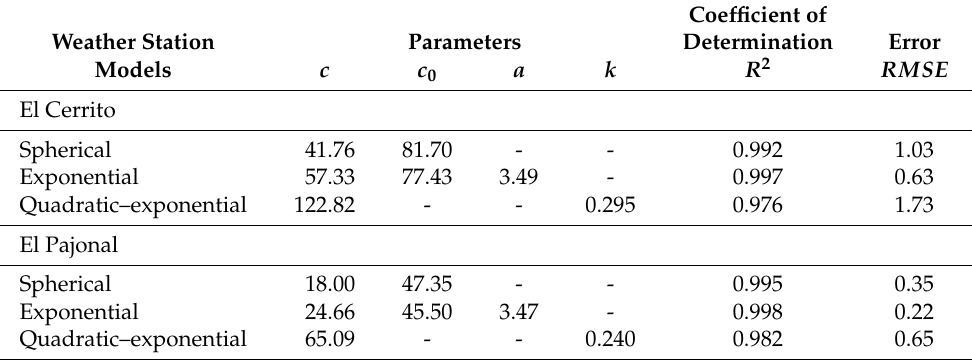
Figure 5. Curve fitting for each station’s variogram with the spherical (2), exponential (4) and quadratic–exponential (8) models. The fitting is carried out considering the corresponding models with the nugget effect. The initial time distance r 0 = 1 month and the maximal variability r = 6 months are tagged with dotted lines. Table 3. Models’ parameters, coefficient of determination R 2 and root-mean-square error ( RMSE ), obtained by fitting each model to each station’s variogram, considering the nugget effect. Parameter a reached the maximal value allowed ( a = 6) in the exponential fitting for the station Casillas, as shown in Table